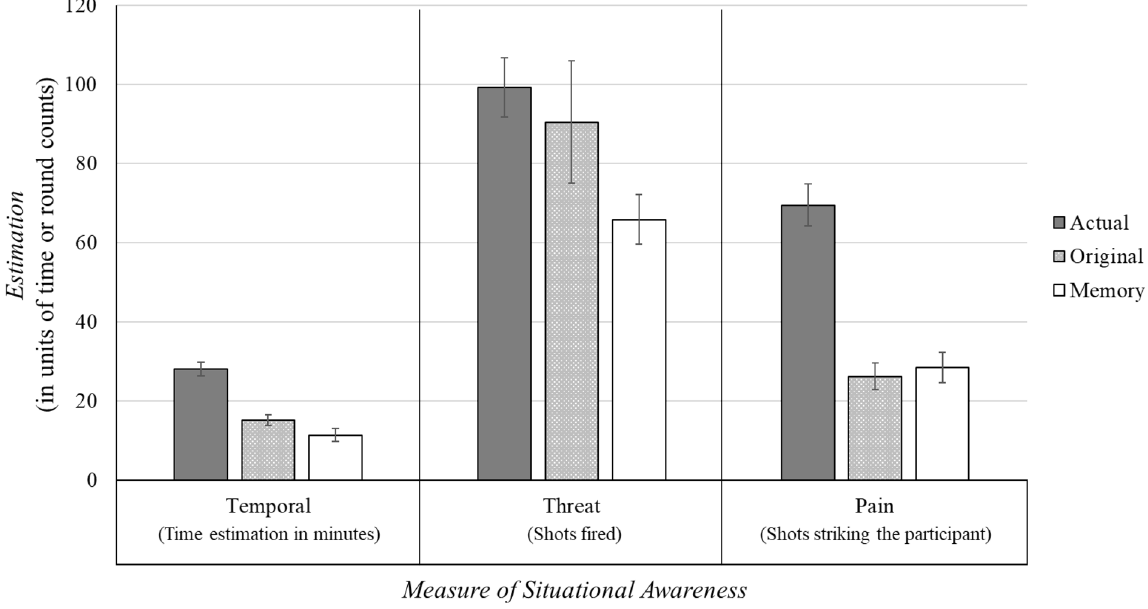
Figure 1. Reported values for the perceptual estimations in the stress-inoculation event, as separated by the actual event (dark grey bars, actual ), reported values immediately after the event (light grey bars, original ), and reported values a week after the event (white bars, memory ). These reported measures are divided between estimations of situational awareness, including: temporal awareness (left, as measured by the total time duration of the event in minutes), threat awareness (middle, as measured by the number of shots fired by the participant at their opponent), and pain awareness (right, as measured by the number of rounds fired by the opponent that struck the participant). Pistol marksmanship and stress prior to the event were used as covariates in these measurements. Error bars show ± 1 standard